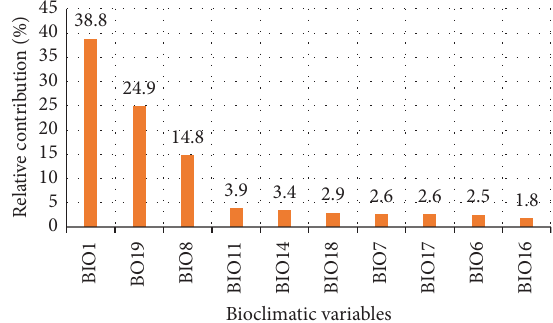
Figure 4: Contribution of each environmental variable to the niche model of E. giganteus